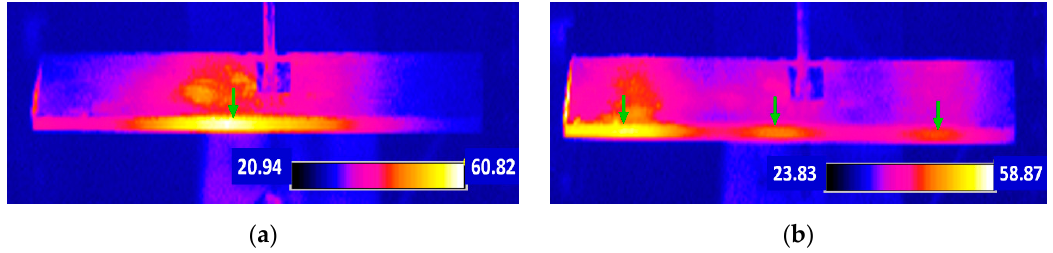
Figure 16. A rectangular piezo-ceramic plate ( L ≫ w ≫ b ) for a longitudinal mode through the transverse piezoelectric effect ( d 31 ).